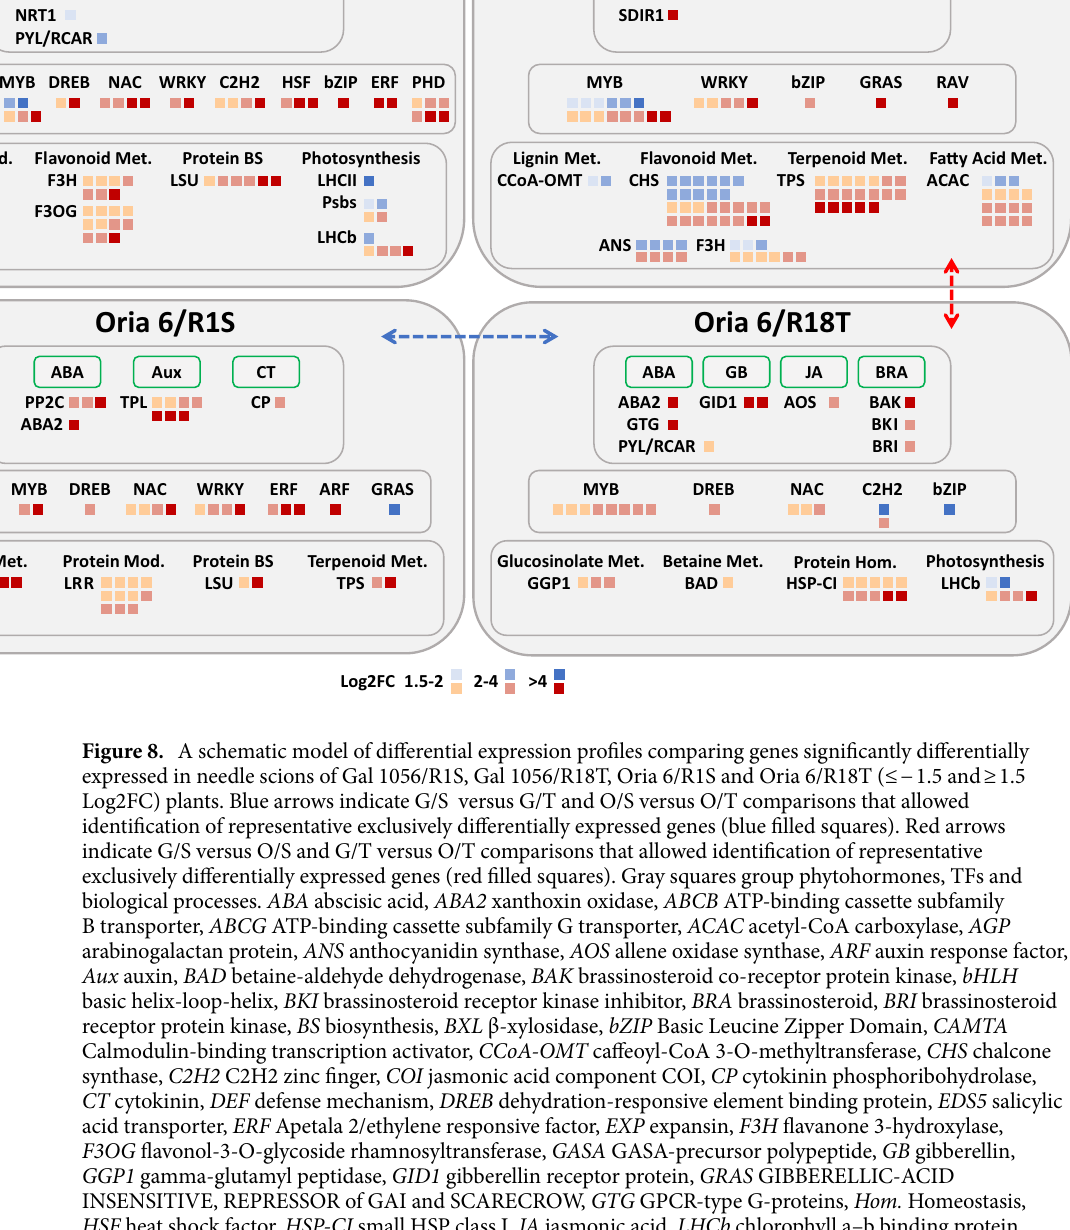
Figure 8. A schematic model of differential expression profiles comparing genes significantly differentially expressed in needle scions of Gal 1056/R1S, Gal 1056/R18T, Oria 6/R1S and Oria 6/R18T (≤ − 1.5 and ≥ 1.5 Log2FC) plants. Blue arrows indicate G/S versus G/T and O/S versus O/T comparisons that allowed identification of representative exclusively differentially expressed genes (blue filled squares). Red arrows indicate G/S versus O/S and G/T versus O/T comparisons that allowed identification of representative exclusively differentially expressed genes (red filled squares). Gray squares group phytohormones, TFs